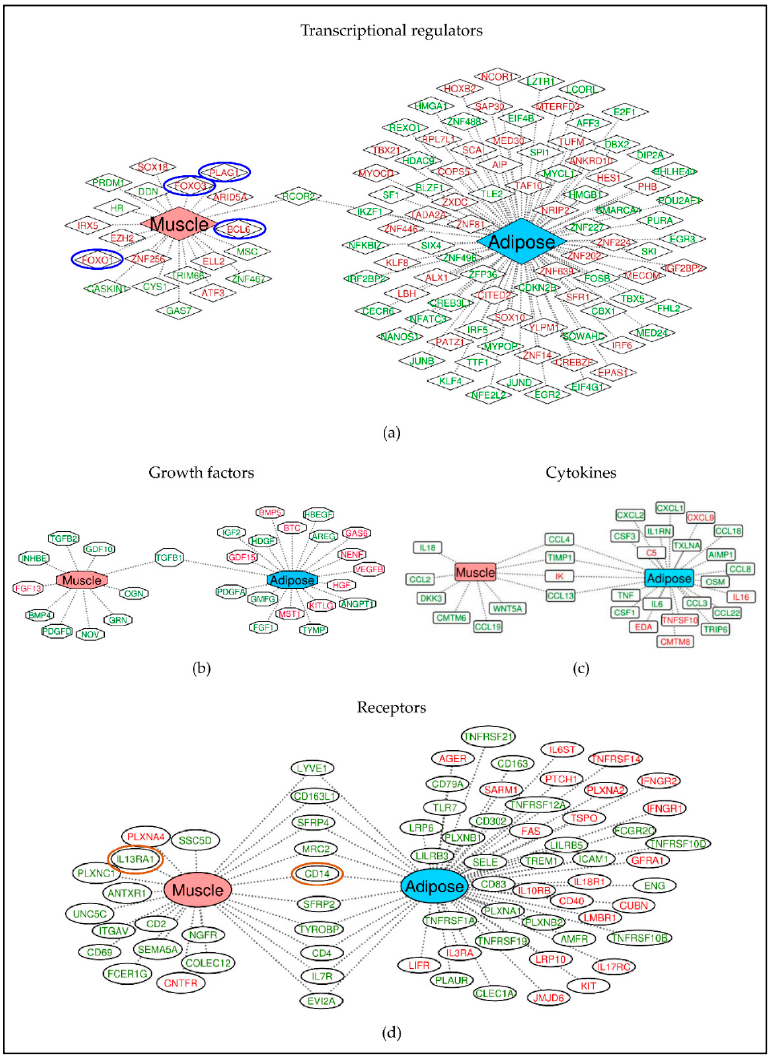
Figure 5. Tissue specific expression of different classes of molecules including transcriptional regulators ( a ), growth factors ( b ), cytokines ( c ) and receptors ( d ). Differentially expressed genes were given as input in IPA and the genes were classified based on their known functions. A strong tissue specific gene expression pattern exists across classes. The genes in red text are upregulated and green text are downregulated genes. The genes represented in between are commonly expressed between muscle and adipose. The genes that are circled in red and blue are also present in aged muscle dataset where the blue circles indicate same direction of effect (upregulated) and red indicates opposite direction of effect (up in one and down in